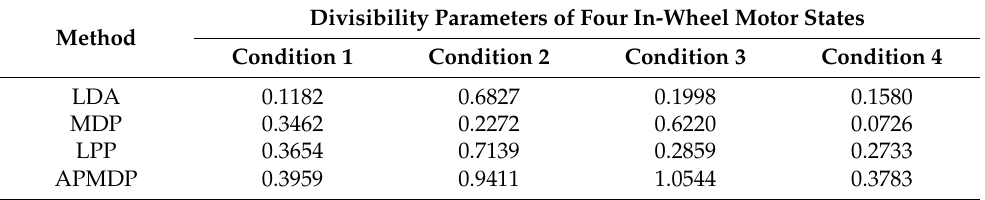
Table 3. Divisibility parameter of four in-wheel motor states by different methods.